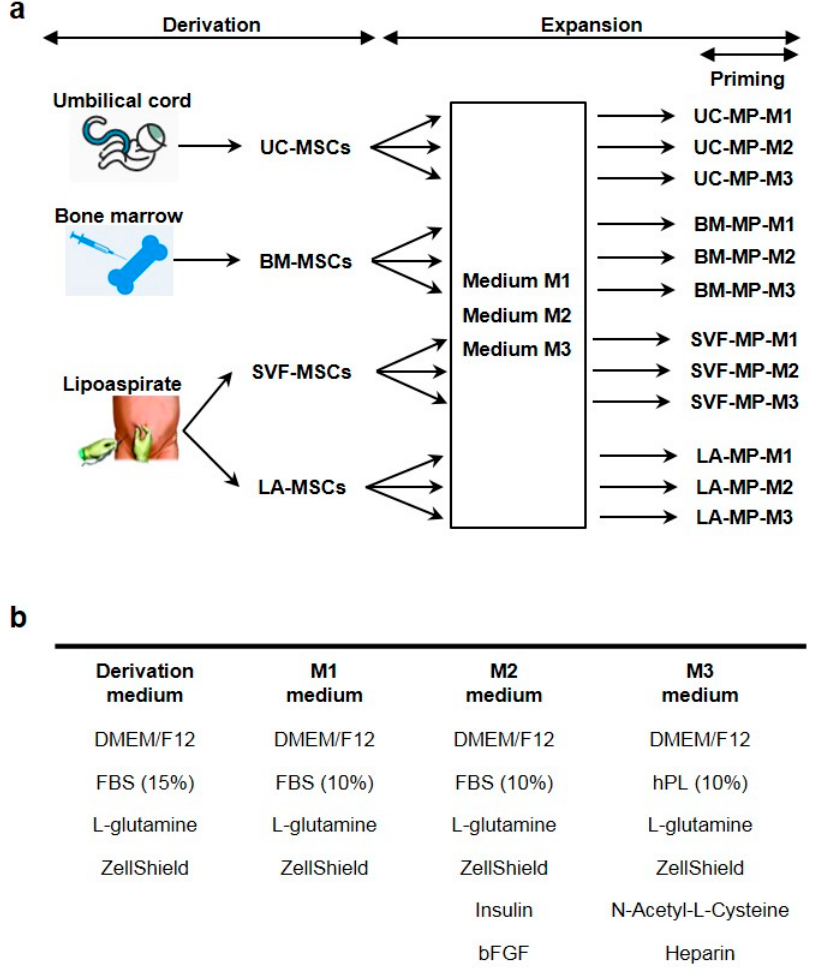
Figure 1. Experiment scheme. ( a ) MSCs were derived from UC, BM and lipoaspirate fractions and expanded in three different media. After expansion tissue-specific MPs were characterized in normal and primed state. ( b ) Derivation and expansion media content, component concentrations are given in the Materials and Methods section.